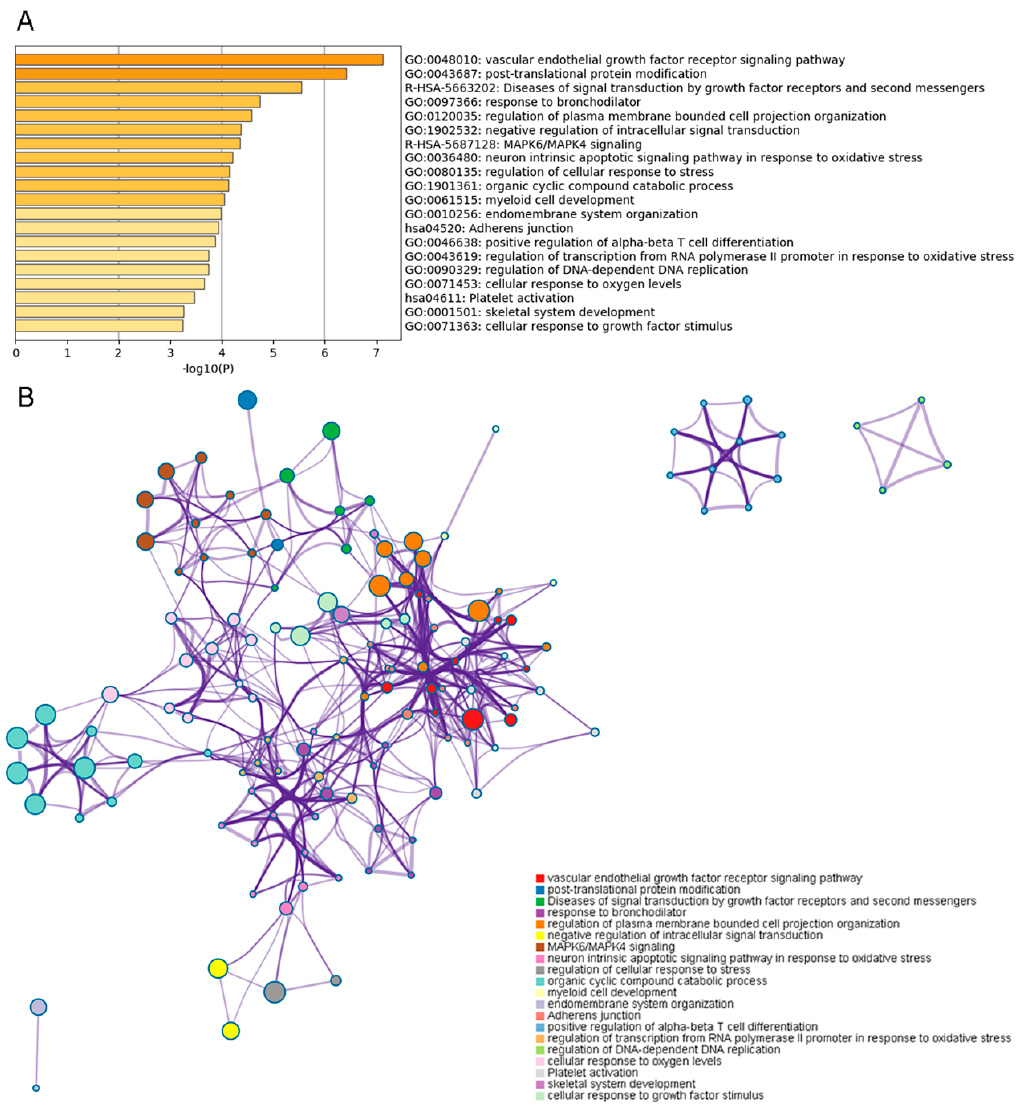
Figure 5. Gene Ontology (GO) cluster and interactome analysis of the genes containing RNA editing. ( A ) Top significant GO biological functions of the genes with RNA editing sites. ( B ) The interactome network of the genes with RNA editing sites. The interaction represents GO-based functional relationship. Different biological functions are represented in different colors.